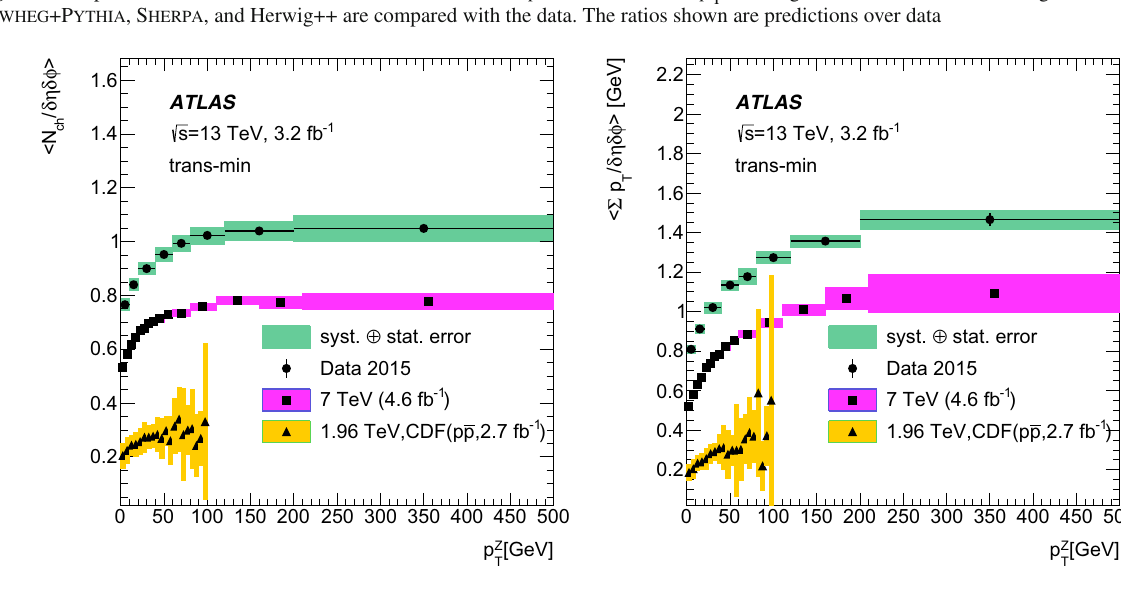
Fig. 13 The distributions of (cid:9) N ch (cid:10) and (cid:9) (cid:8) p T (cid:10) measured at 13 TeVcomparedwiththeresultsofthepreviousATLASmeasurements √ s = 7 TeV [2] and the CDF measurements at at